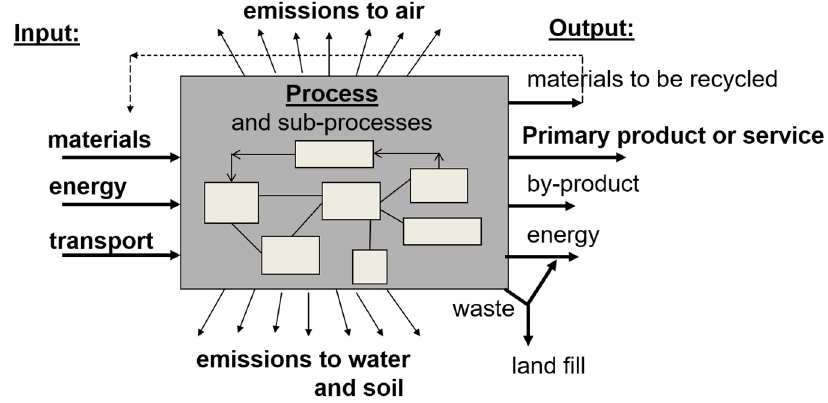
Figure 3. The system components of Life Cycle Assessment.